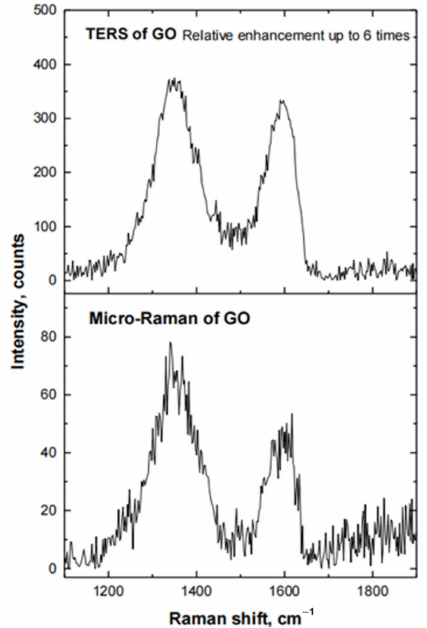
Figure 9. Raman spectra of GO, when the all-metal Au probe, attached to the silicon AFM chip, is in contact with the surface of Si substrate, coated with a film of GO (TERS of GO), and when the Au probe is retracted from the surface of this substrate (Micro-Raman of